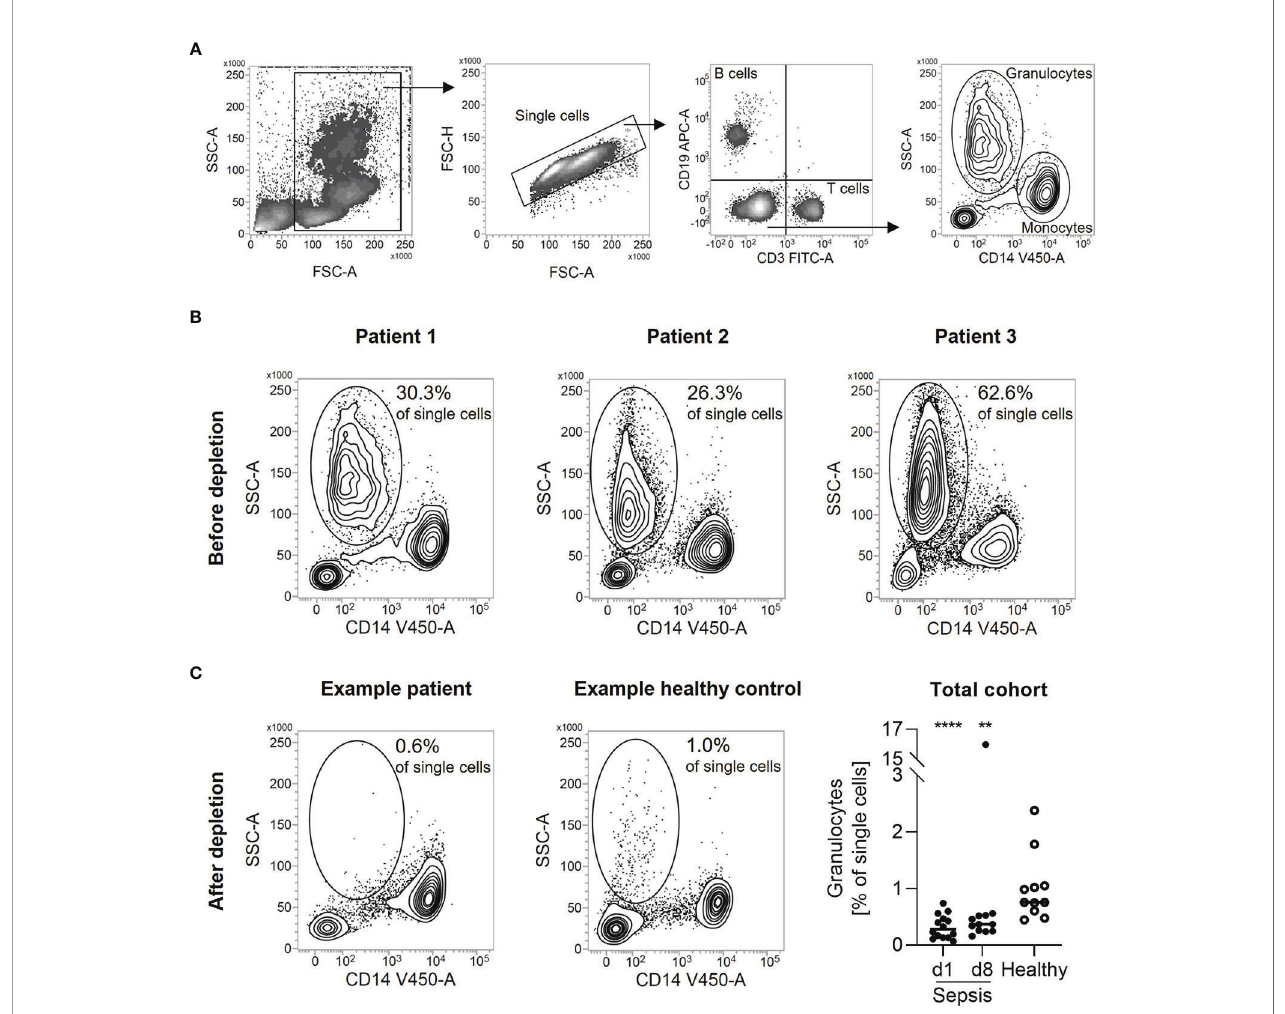
FIGURE 1 | Depletion of CD15 + cells leads to pure PBMC from patients with sepsis. (A) Representative gating strategy for the identi fi cation of low-density granulocytes. Single cells were gated from all cellular events. B cells were identi fi ed as CD19 + . T cells were identi fi ed as CD3 + . Monocytes were identi fi ed as CD14 + . Low-density granulocytes were identi fi ed as CD3 - , CD14 - , CD19 - , SSC hi . (B) Granulocyte percentage in patients with sepsis after density gradient centrifugation. Density plots from three samples selected for analysis are shown. Numbers indicate the proportion of low-density granulocytes in all single cells. (C) Flow cytometric quality control of low-density granulocyte depletion. Representative density plots are shown for patients with sepsis after depletion of CD15 + cells from PBMC isolated by density gradient centrifugation respectively for healthy volunteers after density gradient centrifugation. Numbers indicate the proportion of low-density granulocytes in all single cells. For total cohort, relative percentages of low-density granulocytes after depletion of CD15 + cells are shown (in case of healthy volunteers after density gradient centrifugation). Each data point represents an individual patient (sepsis d1: n = 14; d8: n = 12/healthy: n = 11) and horizontal line marks the median. Group comparisons (sepsis vs . healthy) were performed using Mann-Whitney test (****P < 0.0001, **P ≤